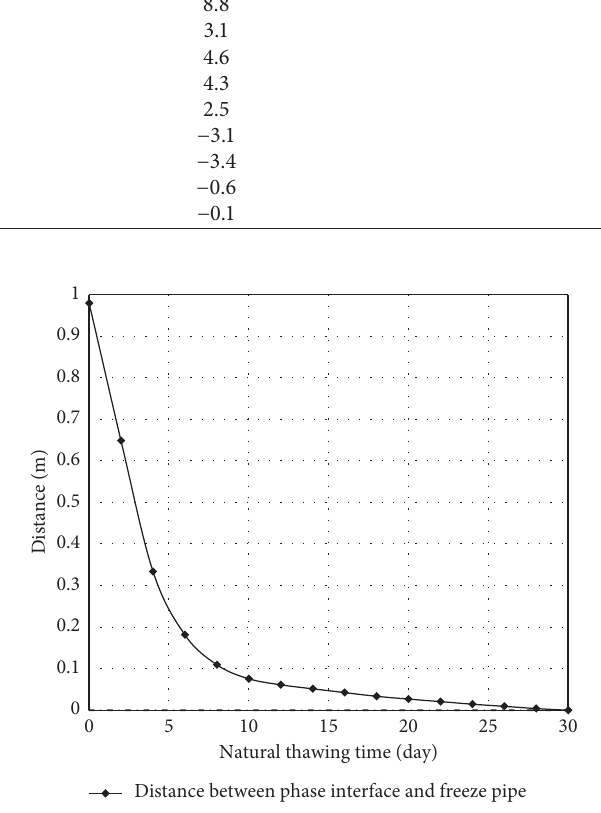
Figure 10: Variation of distance between phase interface and freeze pipe with natural thawing time.